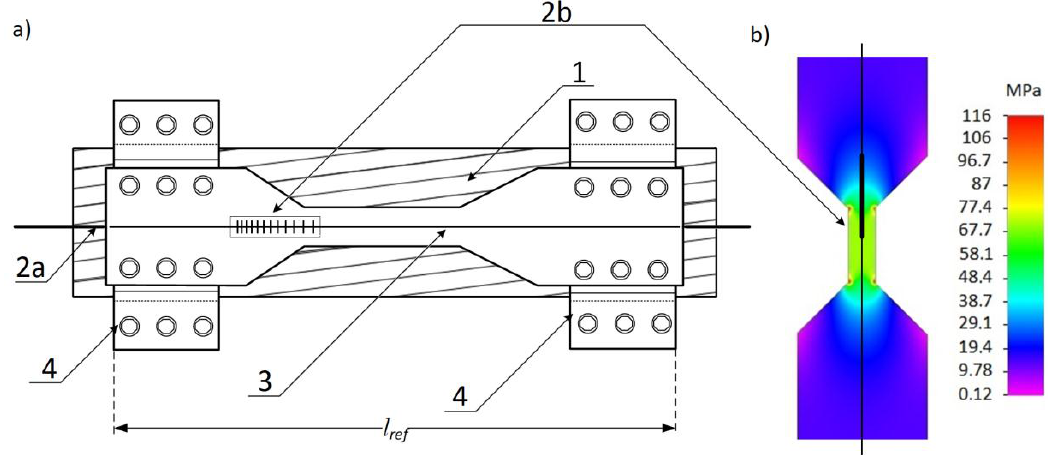
Figure 2. ( a ) the optomechanical system using a chirped fiber Bragg grating and a mechanical strain transformer where: 1: the ACSR 26/7 (Hawk) conductor; 2a: the optical fiber; 2b: the chirped fiber Bragg grating; 3: the thinned steel plate; 4: the semi-circular screwed clamps, l ref : reference sensing head length; and ( b ) the strain distribution in the proposed steel testing plate while extending the measurement section.